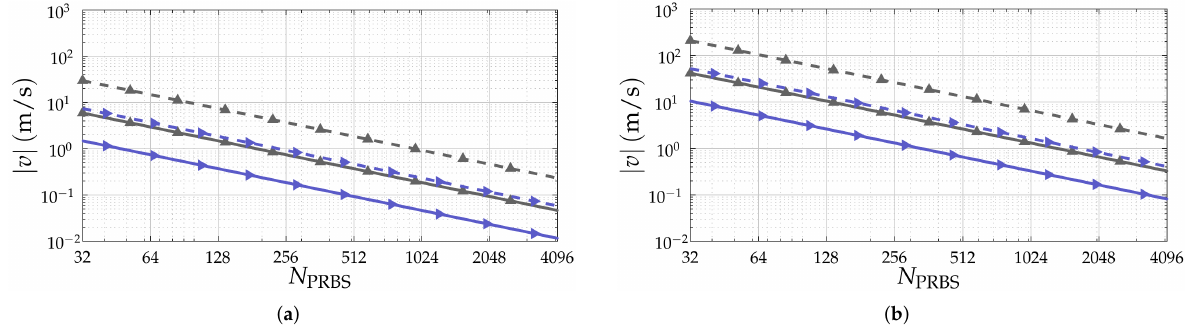
Figure 5. Corresponding relative radial velocity | v | = λ 0 | f D | /2 to normalized Doppler shifts ∆ f | = 0.1 ( — and (cid:73) for combination of complementary sequences Golay A and B with | f D / (cid:78) for remaining PRBSs) and | f ∆ f | = 0.5 ( – – and (cid:73) for = N N Golay D / PRBS for each, and — and CP = N combination of complementary sequences Golay A and B with N Golay PRBS for each, and – – and CP (cid:78) for remaining PRBSs) for the considered ( a ) automotive and ( b ) gesture recognition